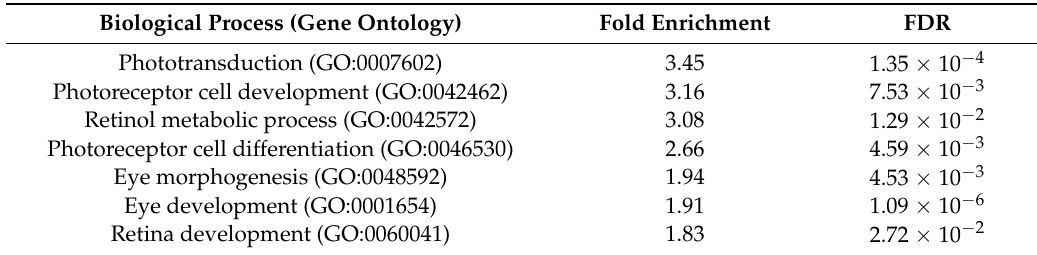
Table 1. Transcriptome data set of